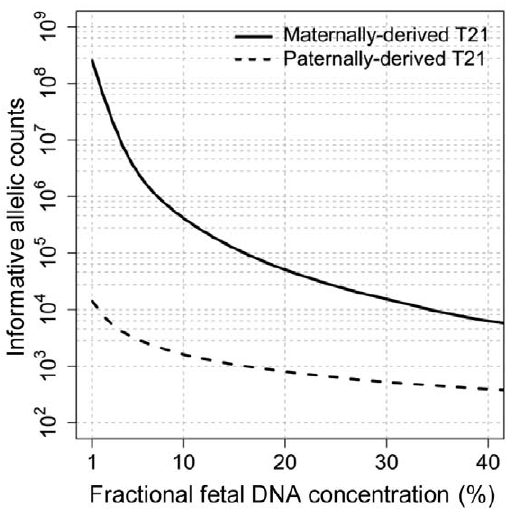
Figure 4. Computer simulation to investigate the minimal number of informative allelic counts for T21 detection. The solid curve represents the minimal number of informative allelic counts required on each of chr21 and chrRef (Y axis), in order to achieve a reliable detection in maternally-derived T21 (sensitivity . 99%, speci- ficity . 99%) according to a given fractional fetal DNA concentration (X axis). The dash curve represents the paternally-derived T21 model.